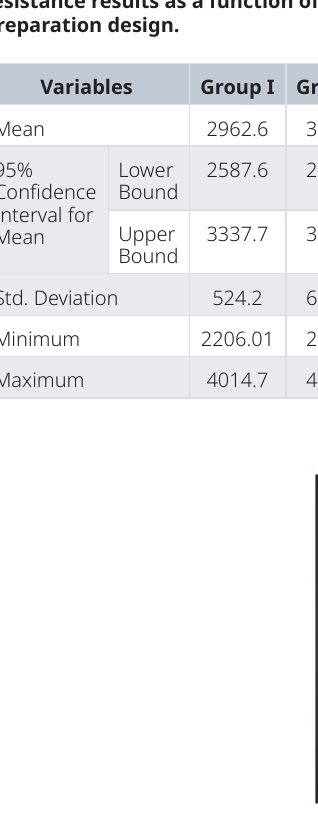
Figure 6. Column chart of fracture resistance mean values for both preparation designs.